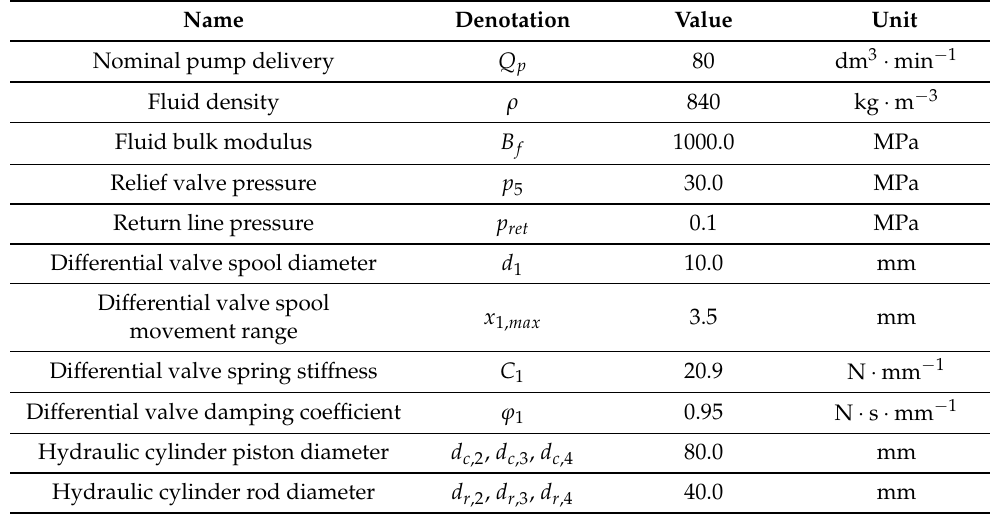
Table 1. Physical model parameters.